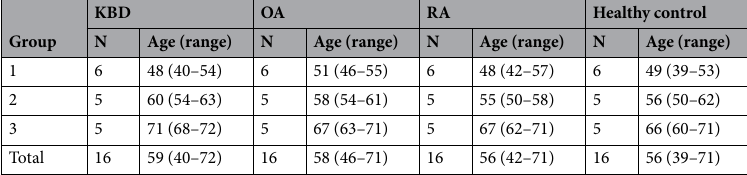
Table 3. Basic characteristics of study subjects for miRNA expression profile